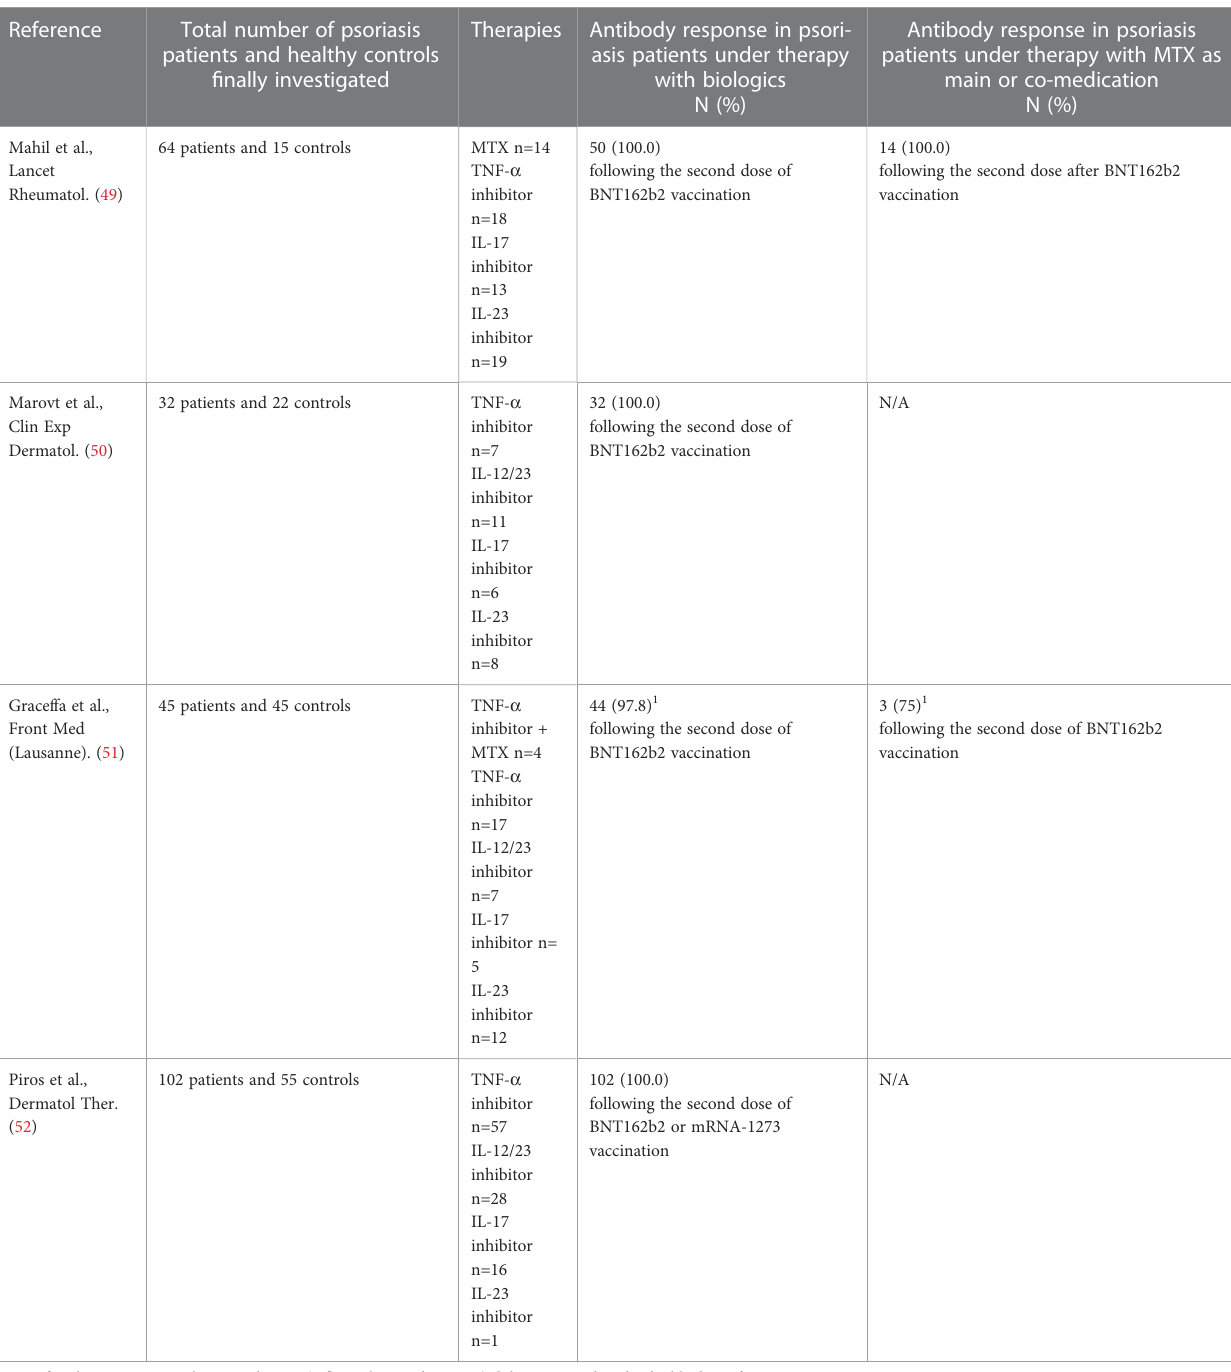
TABLE 4 Results of other studies investigating the serological response to COVID-19 vaccination in psoriasis patients.